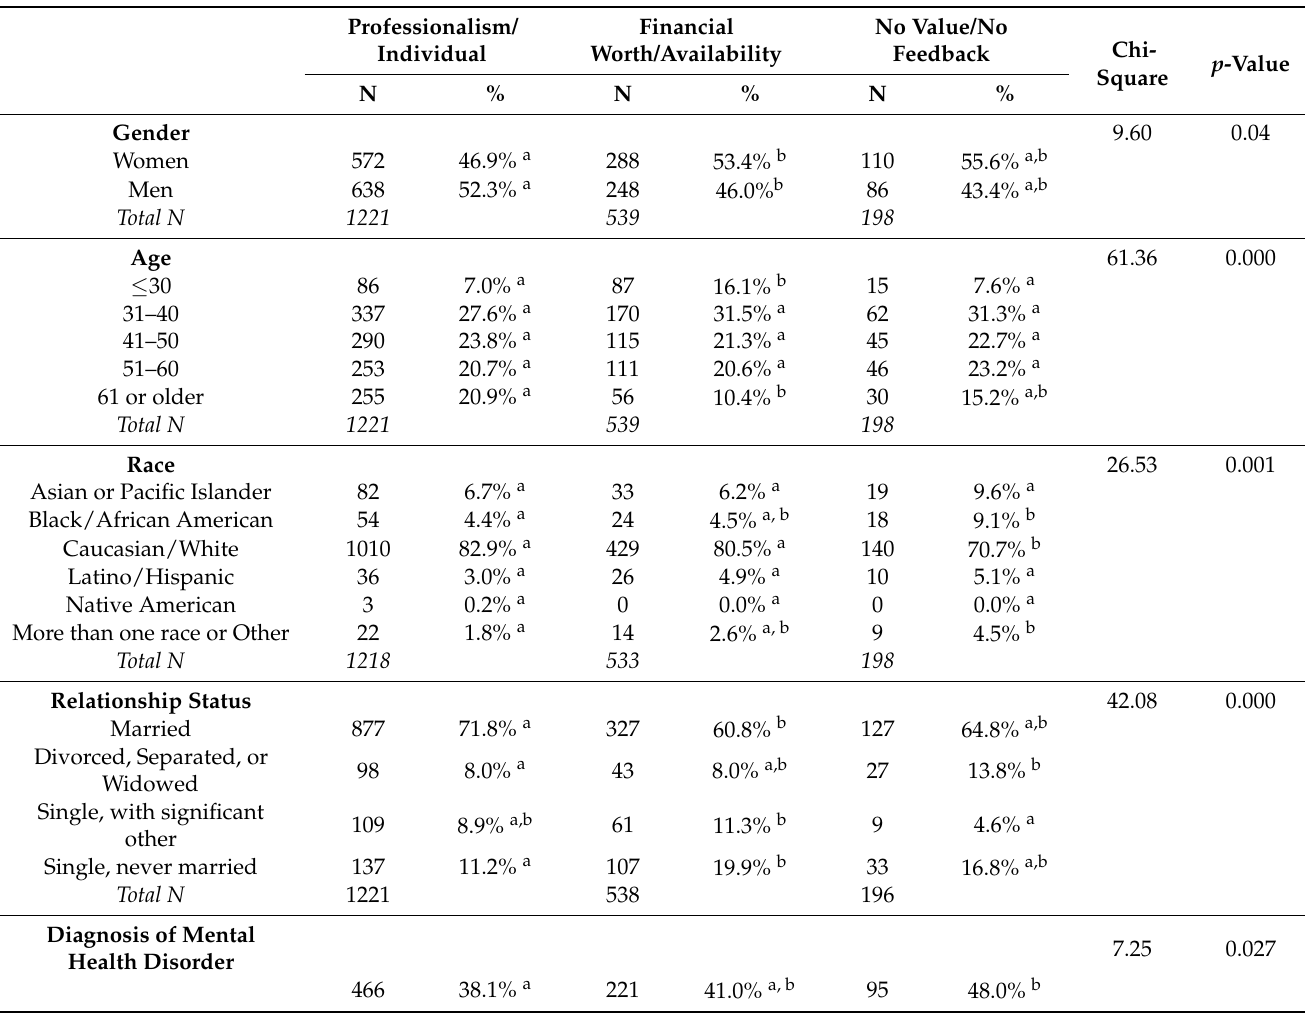
Table 2. Sociodemographic variables.